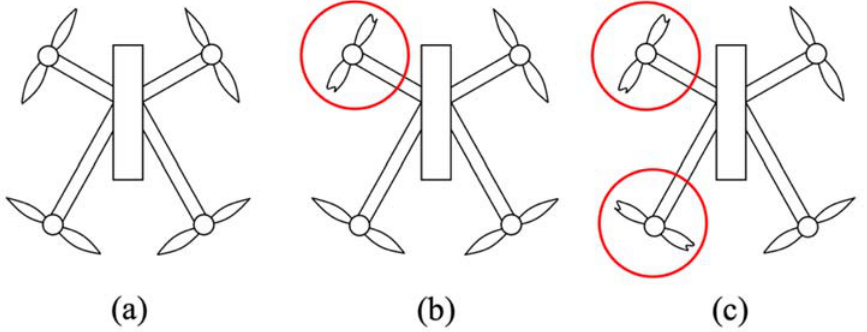
Figure 3. Cases for Propeller Faults with ( a ) Healthy, ( b ) One Set of Faulty Propellers (1SFP), and ( c ) Two Sets of Faulty Propellers